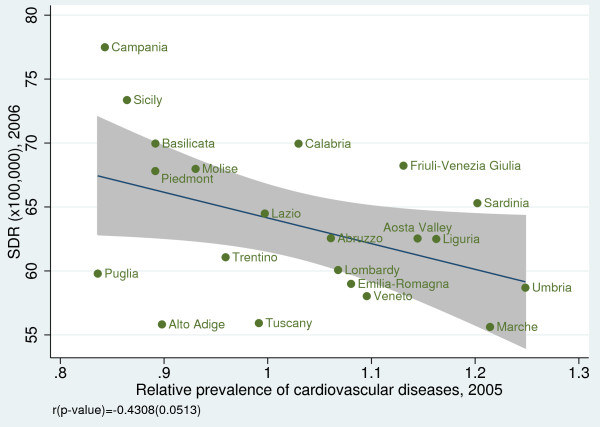
Amenable mortality vs. relative prevalence of cardiovascular diseases, including stroke, hypertension, acute myocardial infarction, and angina pectoris. Data source: Indagine Istat su condizioni di salute e ricorso ai servizi sanitari 2004–2005 [15].